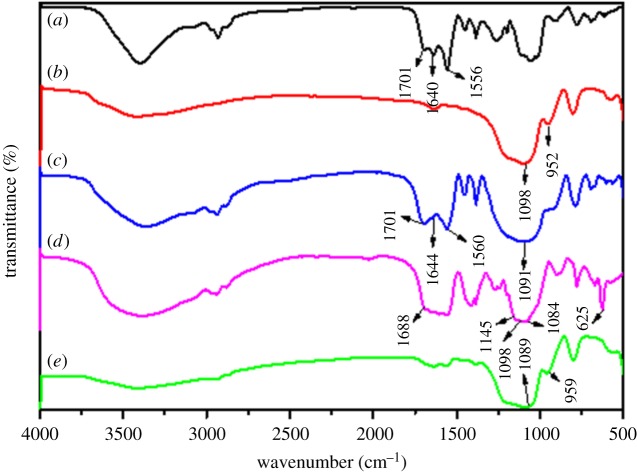
FT-IR spectra of ANA-Si (a), SiO2 (b), SiO2@ANA-Si (c), SiO2@ANA-Si-Tb (d) and SiO2@ANA-Si-Tb@SiO2 (e).